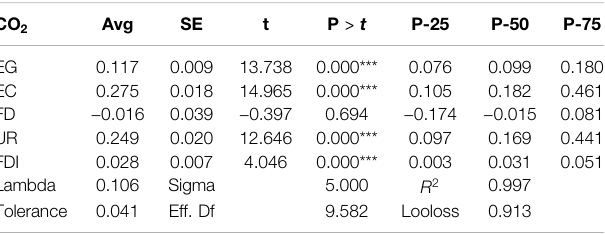
TABLE 6 | Pointwise derivatives using KRLS.